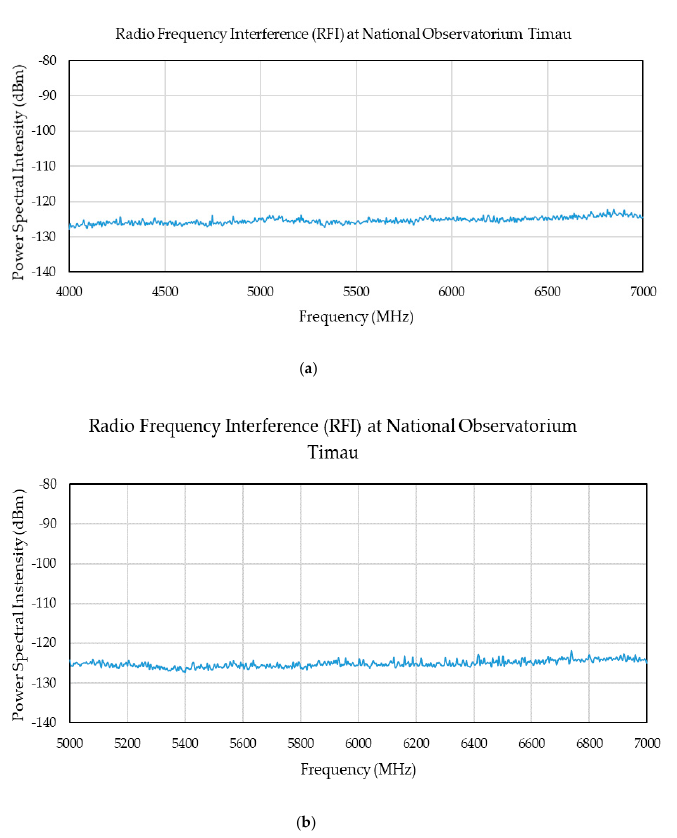
Figure 10. Results of radio frequency measurement at the following frequencies: ( a ) between 4000 and 7000 MHz, using a log-periodic antenna; ( b ) between 5000 and 7000 MHz, using a dipole antenna.